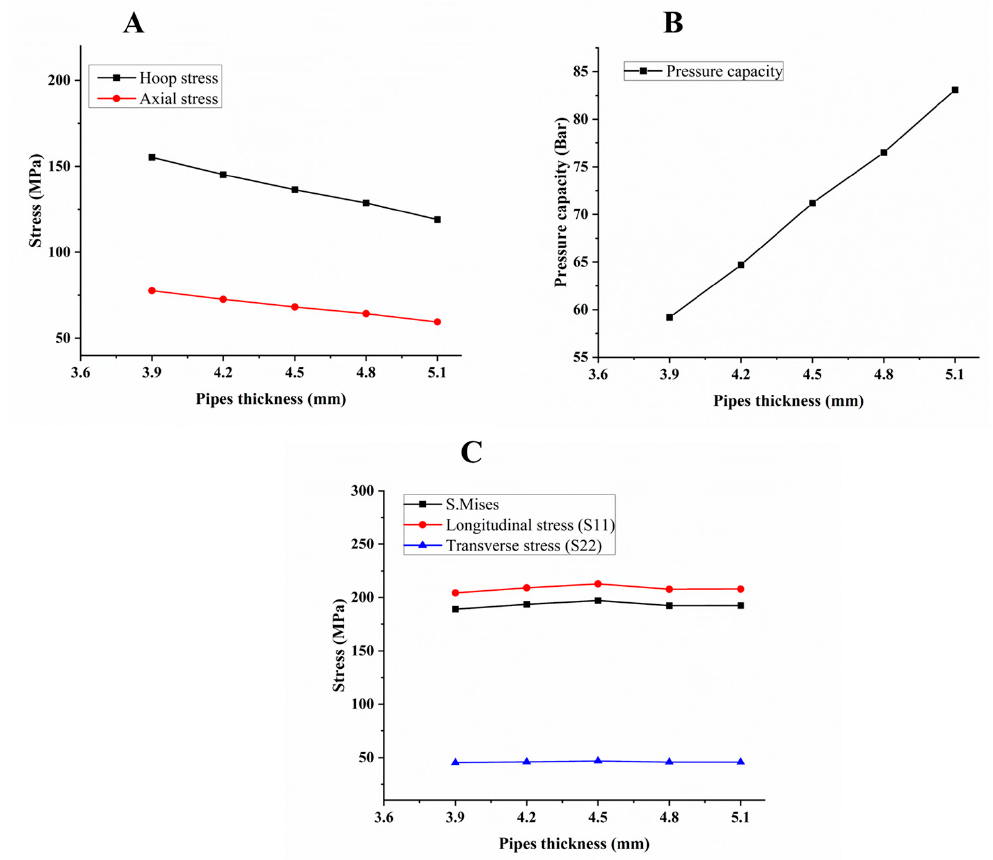
Figure 6. Hoop and axial stress ( A ), pressure capacity ( B ), and various stress ( C ) of [ ± 55] 3 composite pipes with different thicknesses .